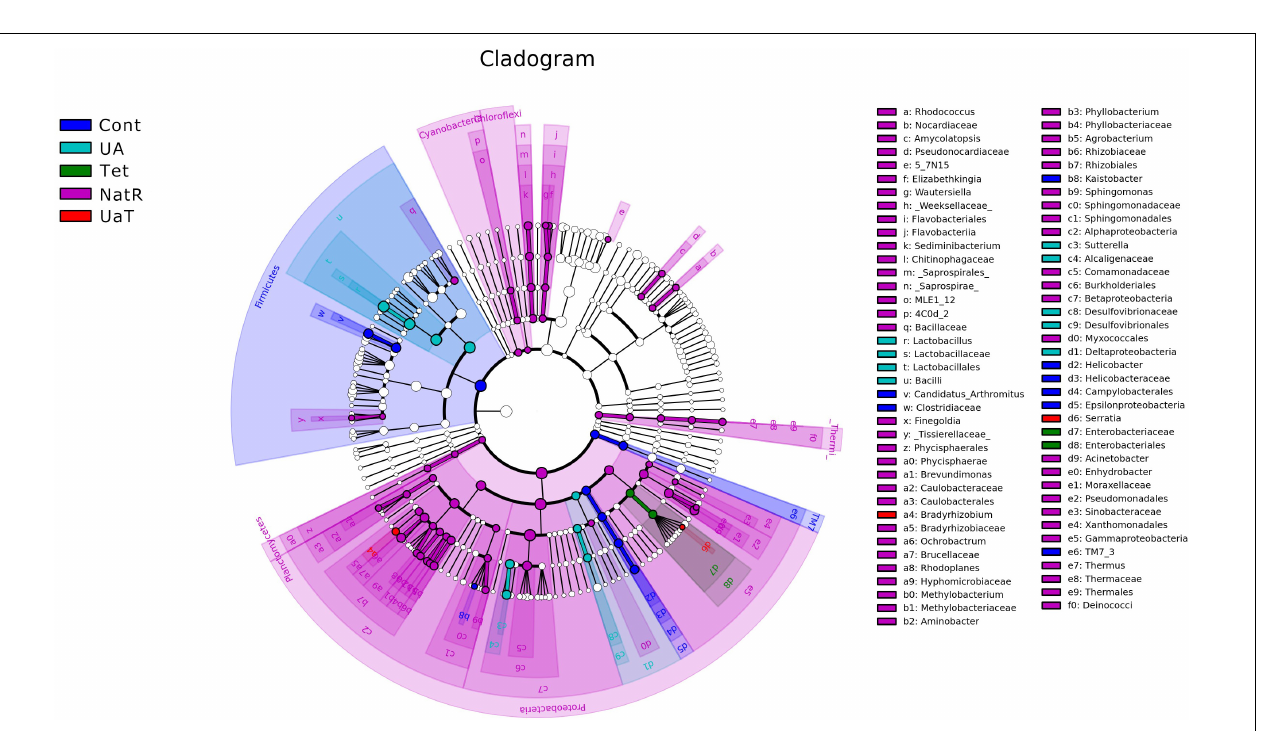
Frontiers in Physiology |